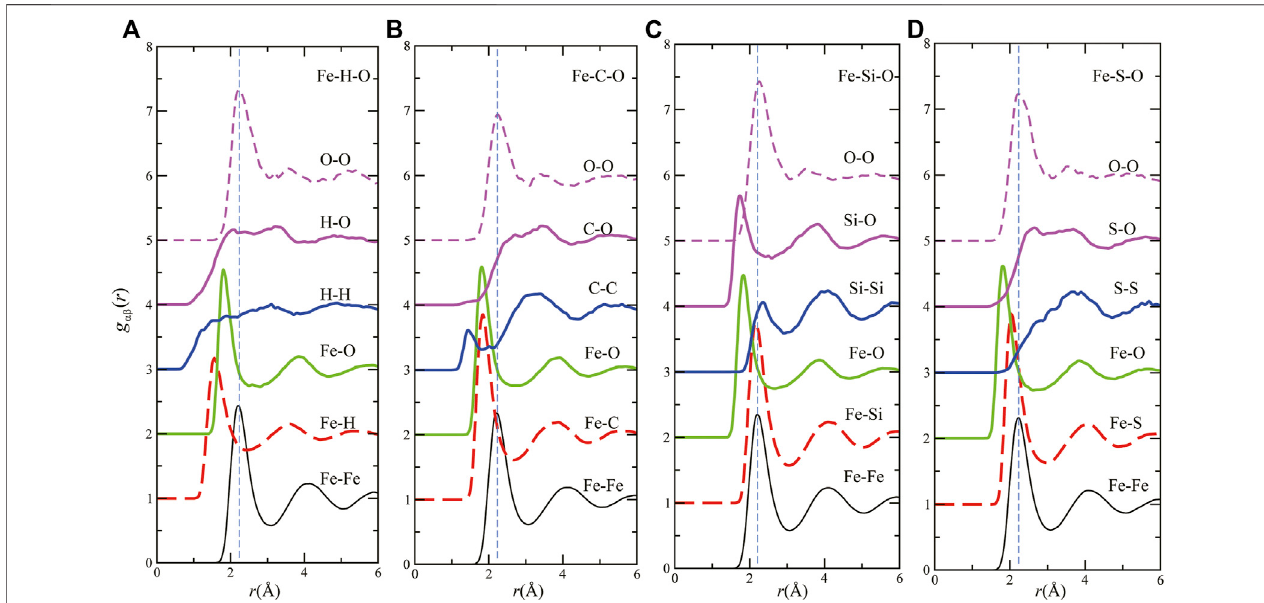
FIGURE 2 | Partial pair distribution functions of liquids (A) Fe 160 H 20 O 20 (Fe – H – O), (B) Fe 160 C 20 O 20 (Fe – C – O), (C) Fe 160 Si 20 O 20 (Fe – Si – O) and (D) Fe 160 S 20 O 20 (Fe – S – O) at 140 GPa and 5000 K.